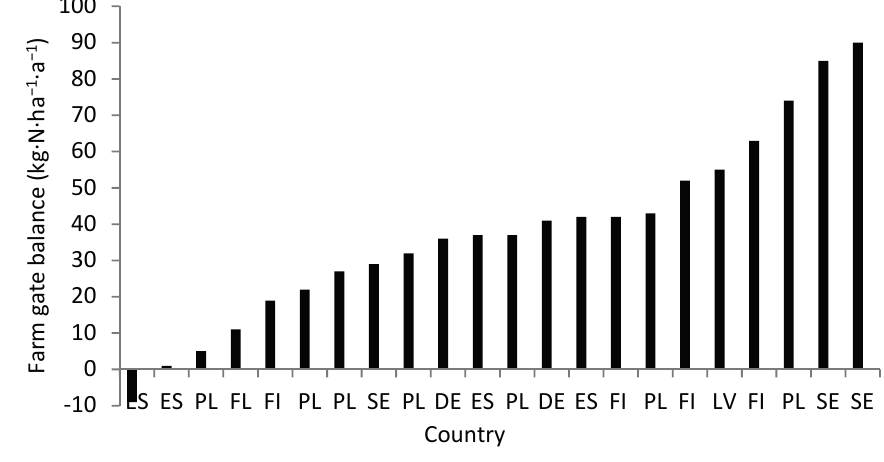
Figure 1. Farm gate N balances of 22 farms from Estonia (ES), Finland (FI), Germany (DE), Latvia (LV), Poland (PO) and Sweden (SE) in the Baltic Sea catchment area